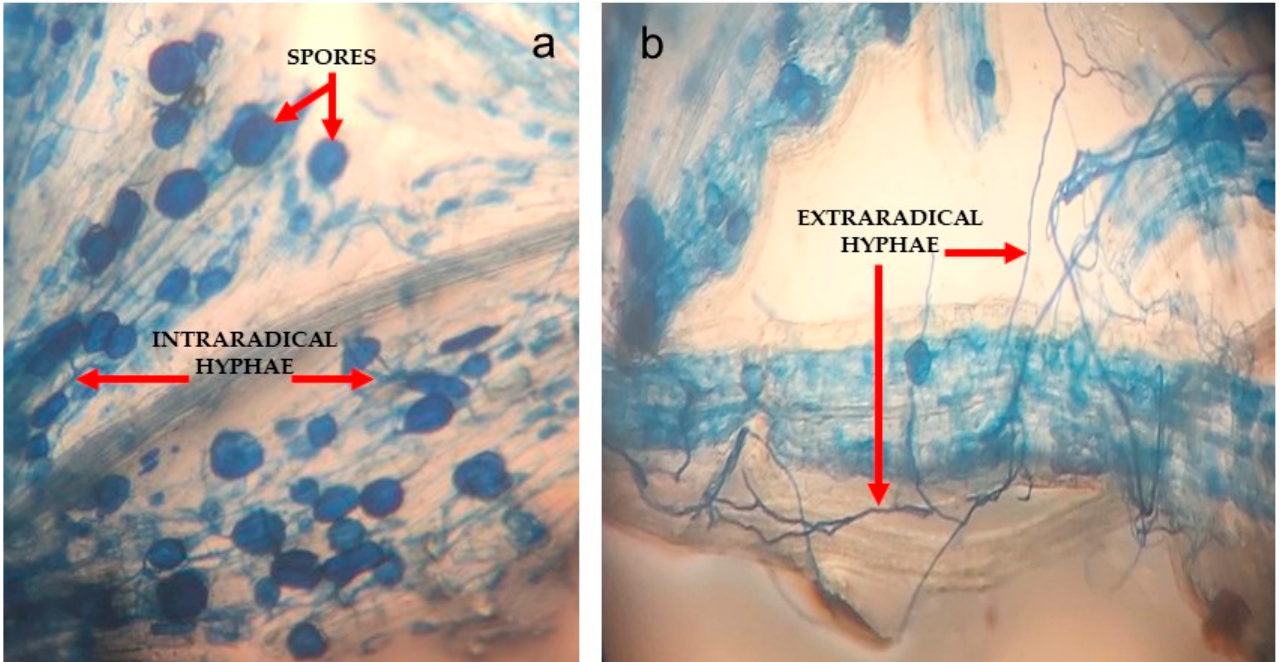
Figure 3. Symptoms of the establishment of a symbiotic relationship among AMF and the root of Salvia abrotanoides (×10 objective lens); ( a ) spores and intraradical hyphae; ( b ) extraradical hyphae. The fresh root systems were stained with 0.05% w/v trypan blue in lactoglycerol (8:1:1 lactic acid, glycerol, and